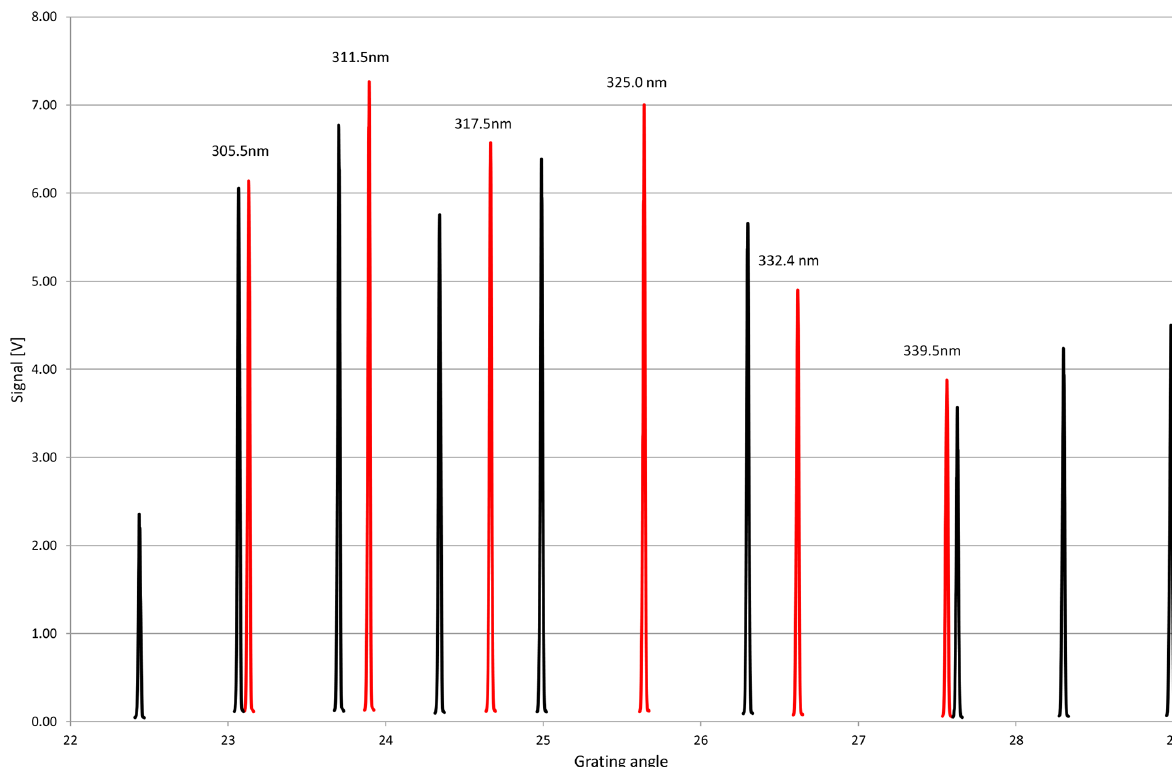
Figure 4. TuPS wavelength calibration with CMI OPO facility. In red the values of interest for the Dobson